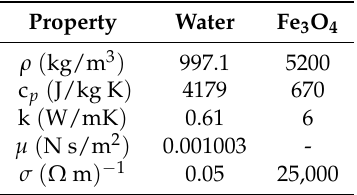
Figure 1. Schematic view of the physical model with boundary conditions. Table 1. Thermophysical properties of water and Fe 3 O 4